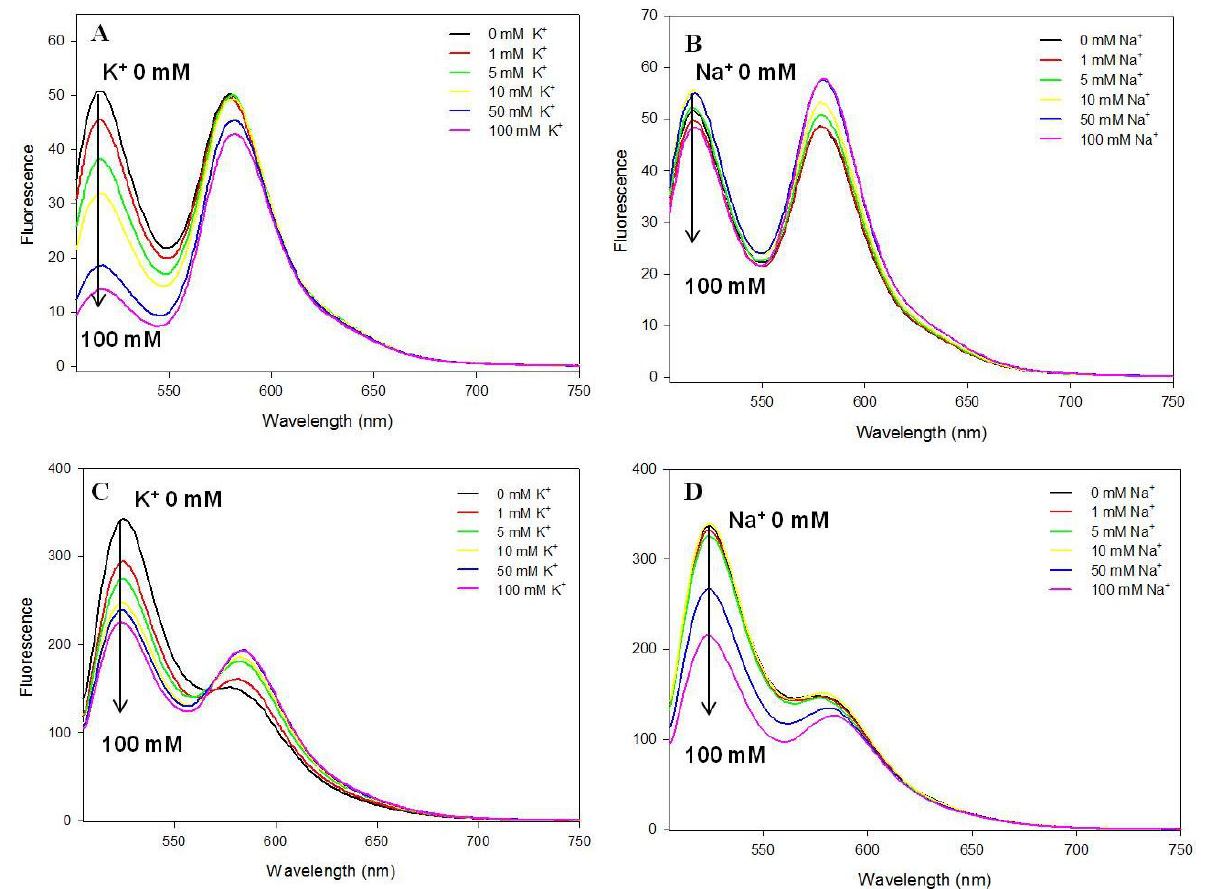
Figure 7. Potassium and sodium ions’ effect on the fluorescence spectra of 0.2 μM F19T ( A , B , respectively) and ChF19T ( C , D , respectively) with λ ex = 490 nm. Conditions: 10